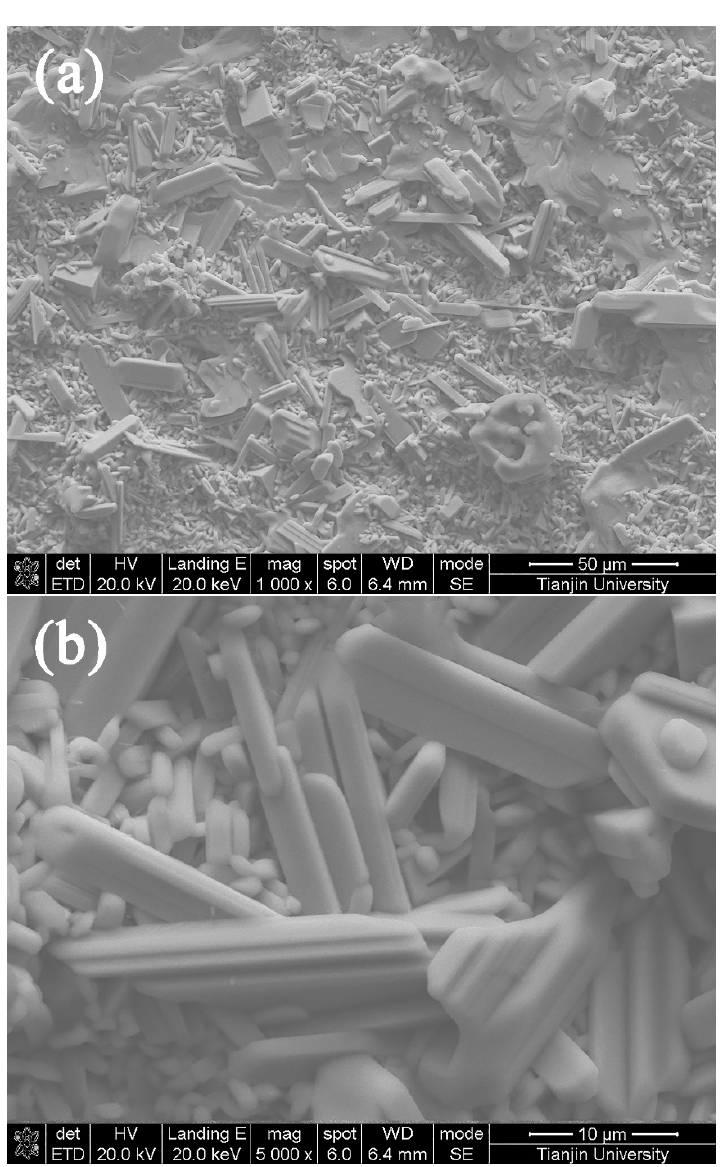
Figure 6. Surface morphologies of BaNd 2 Ti 3 O 10 pellet after Na 2 SO 4 + V 2 O 5 molten salt corrosion at 1000 °C for 4 h. ( a ) and ( b ) show the images with different magnifications.